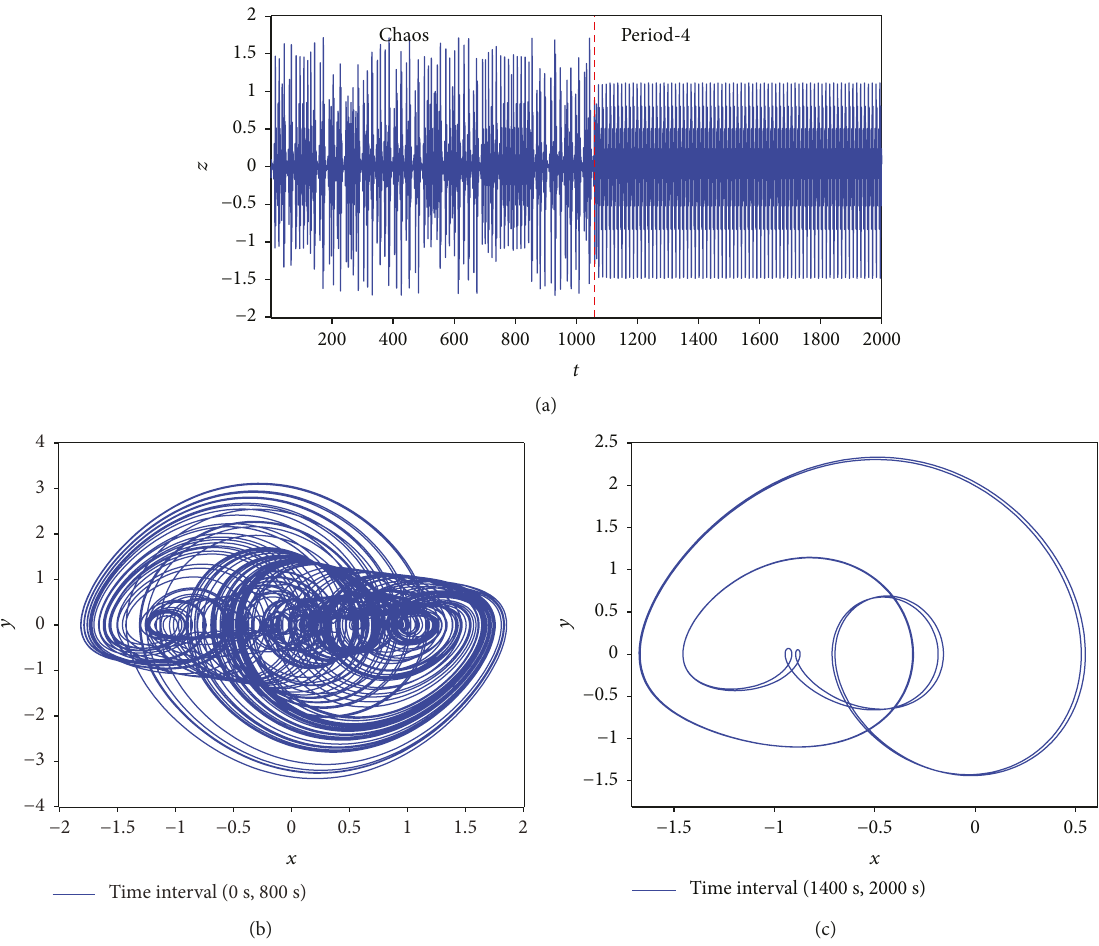
Figure 11: (a) Time-domain waveform of variable z in the region of (0 s, 2000s); (b) the phase portrait in time interval of (0 s, 800 s); (c) the phase portrait in time interval of (1400s, 2000 s).